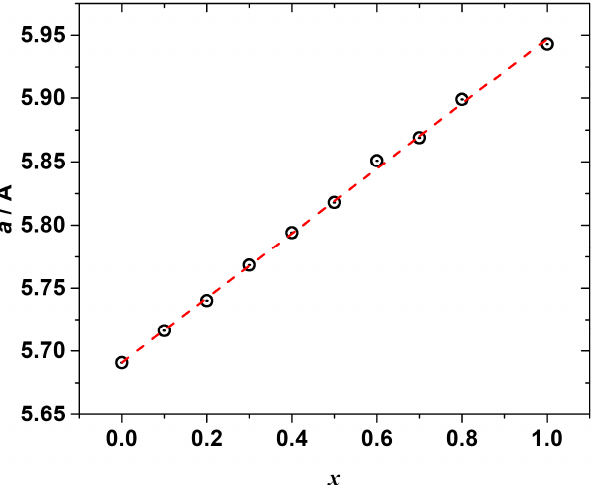
Figure 3. The refined cubic lattice parameter a of the synthesized mixed halide perovskites CH 3 NH 3 Pb(Cl 1 − x Br x ) 3 as a function of composition x (black circles), red dashed line represents a linear fitting.